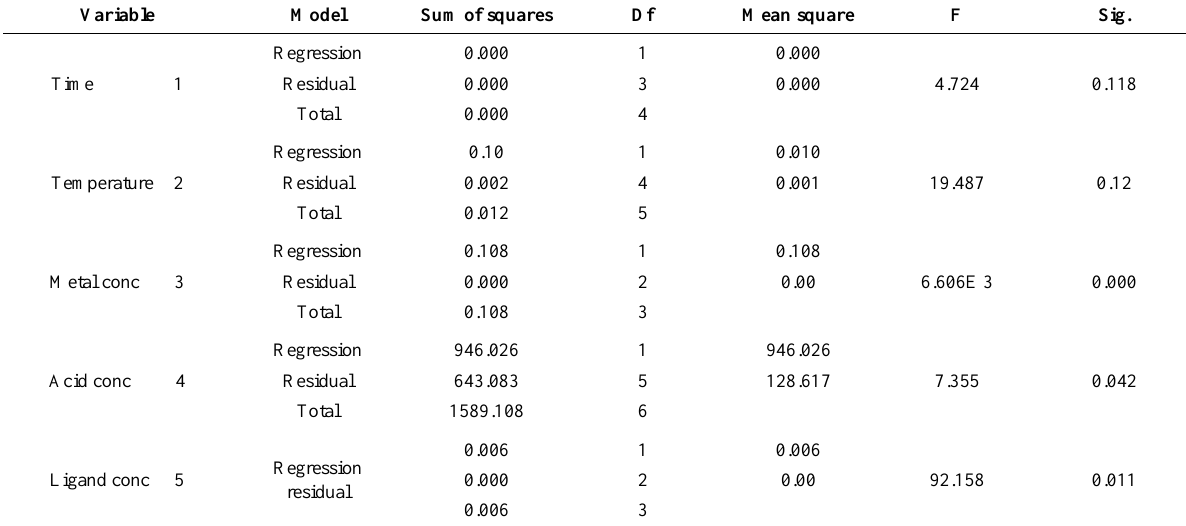
Table 2. Results of the ANOVA test for the preparation and extraction of Mn(II) H 2 SAL Complex